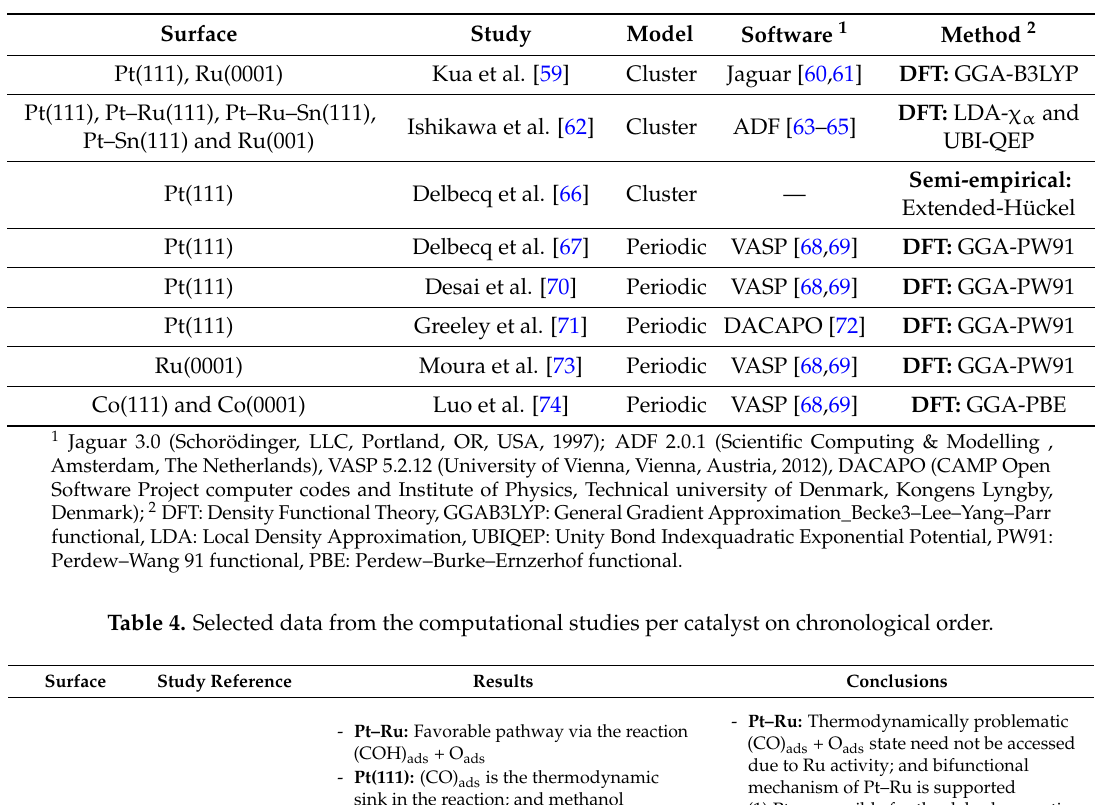
Table 4 has the following vertical entries: (1) type of catalytic surface; (2) study reference; (3) results; and (4) conclusions. Table 3. Reviewed computational studies (models, methodologies and surfaces).